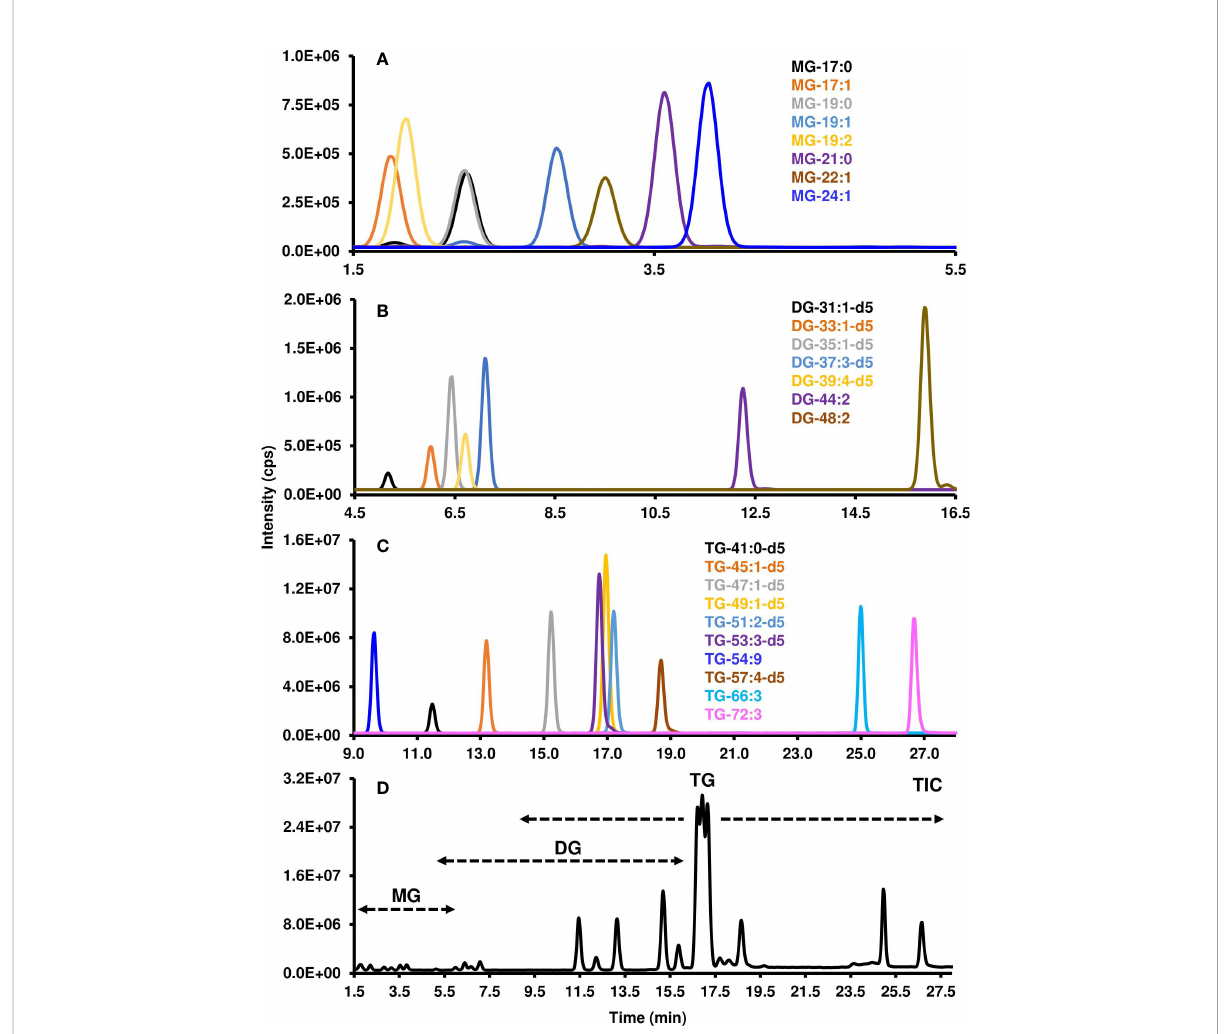
FIGURE 4 Chromatographic resolution and detection of non-polar lipids using LC-MS/MS. MRM scan survey was conducted to obtained the XIC of the different (A) MGs, (B) DGs, and (C) TGs. Each individual XIC represents a transition of precursor/product ion that was determined as indicated in the Materials and Methods as well as Tables 1, 2. (D) Total Ion Count (TIC) which depicts the the total number of ions at a speci fi c chromatographic time. MG, Monoacylglycerol; DG, diacylglycerol; TG, triacylglycerol. Each lipid class is characterized by its number of carbon atoms and double bonds. “ d5 ” indicates the glycerol part of the lipid has fi ve deuterium instead of hydrogen